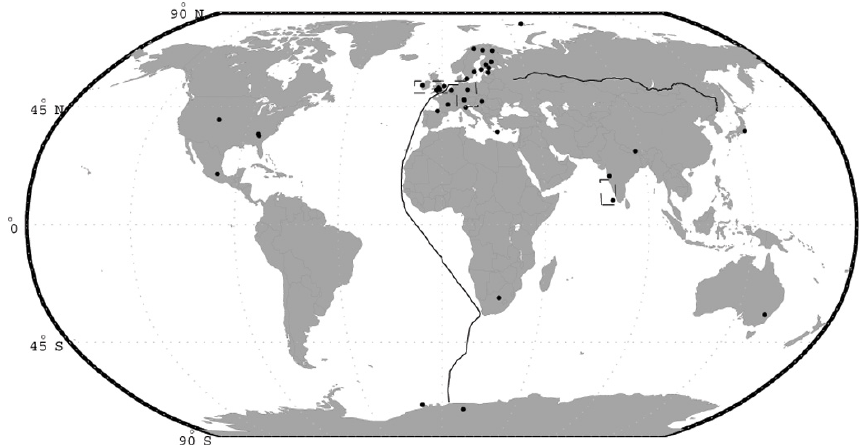
Fig. 2. The map of the world: measurement sites are indicated with black dots, the trip by train through Siberia, Russian, and boat trip from Europe to Antarctica with black curve.